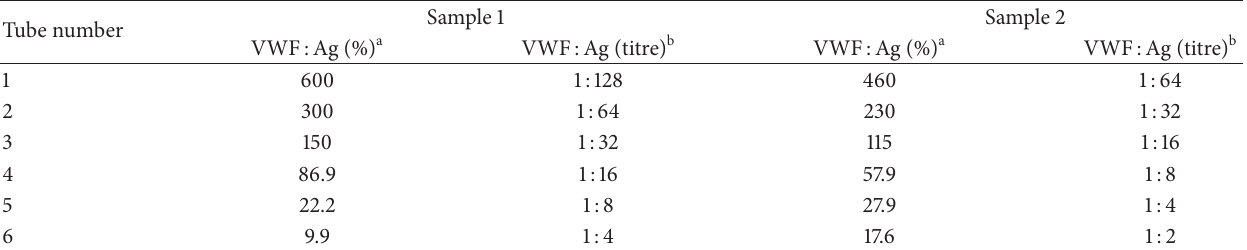
Table 3: Linearity study on semiquantitative VWF antigen by latex agglutination test. Tube number